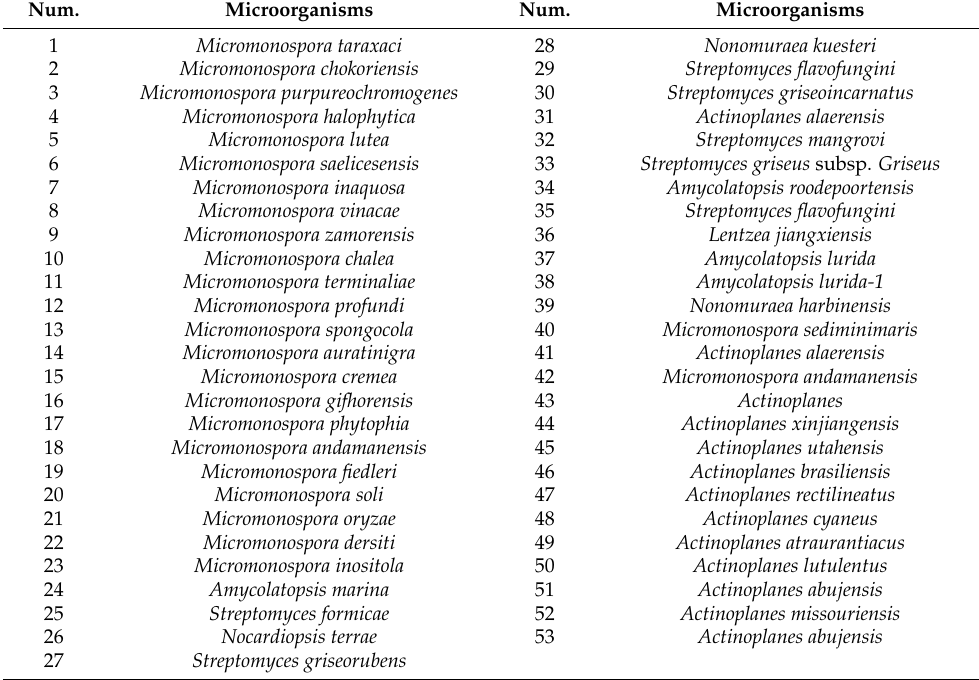
Table 2. All isolated and identified microorganisms.